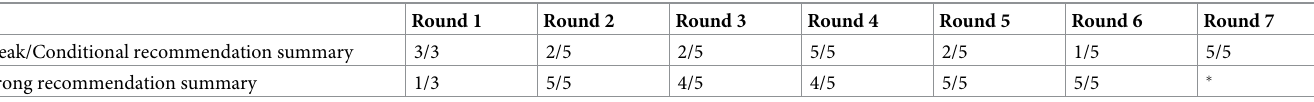
Table 2. Number of participants with good understanding of the recommendation. Round 1 Round 2 Round 3 Round 4 Round 5 Round 6 Round